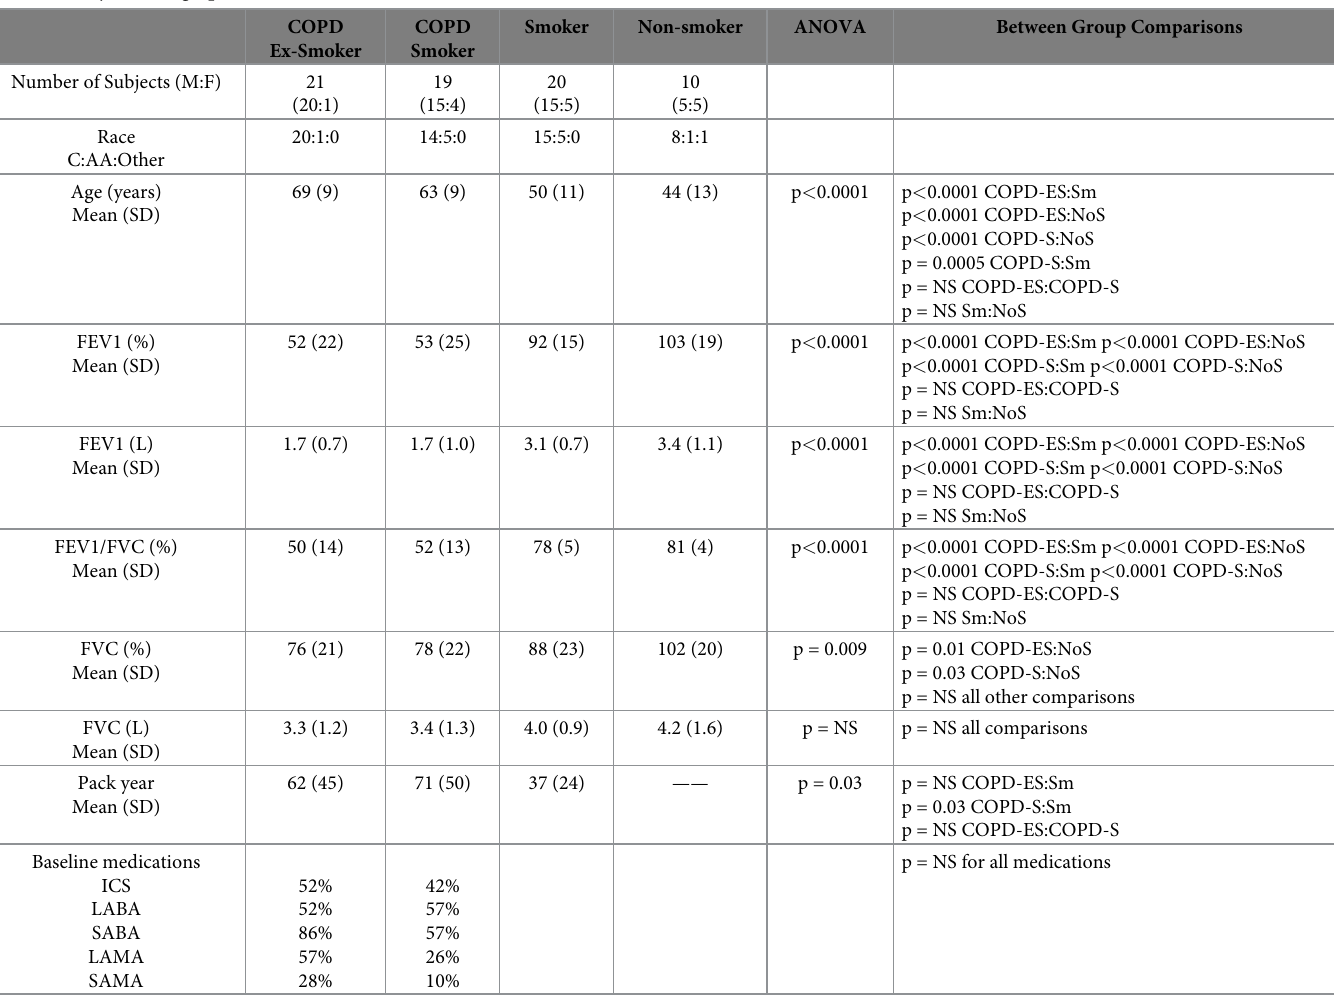
Table 1. Subject demographics.